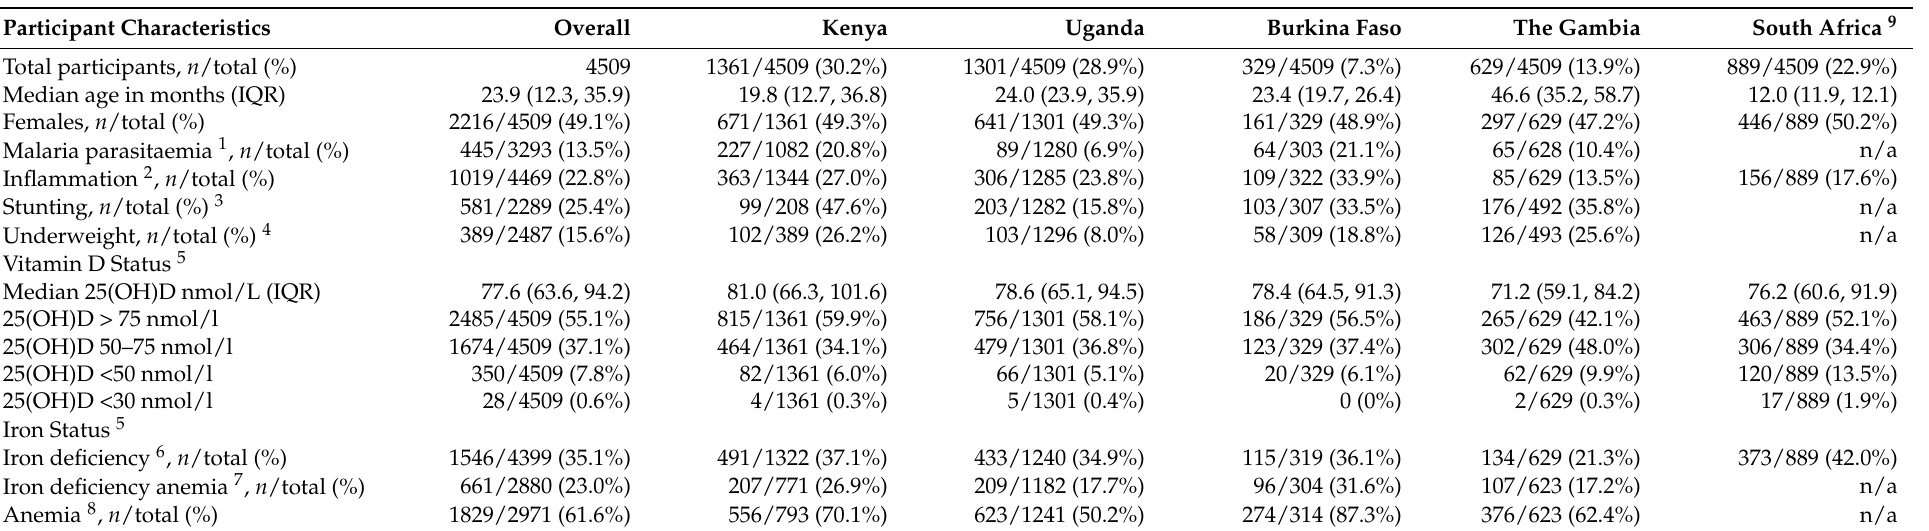
Table 1. Characteristics of study